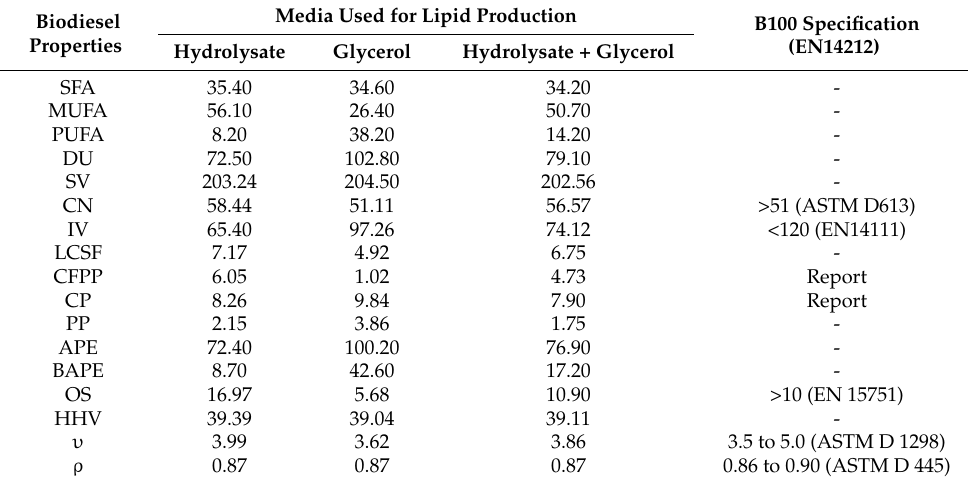
Table 4. Biodiesel properties estimated by BiodieselAnalyzer © program using fatty acid profiles of the lipid from R. glutinis 5159 cultivated in hydrolysate, glycerol, and hydrolysate mixed with glycerol